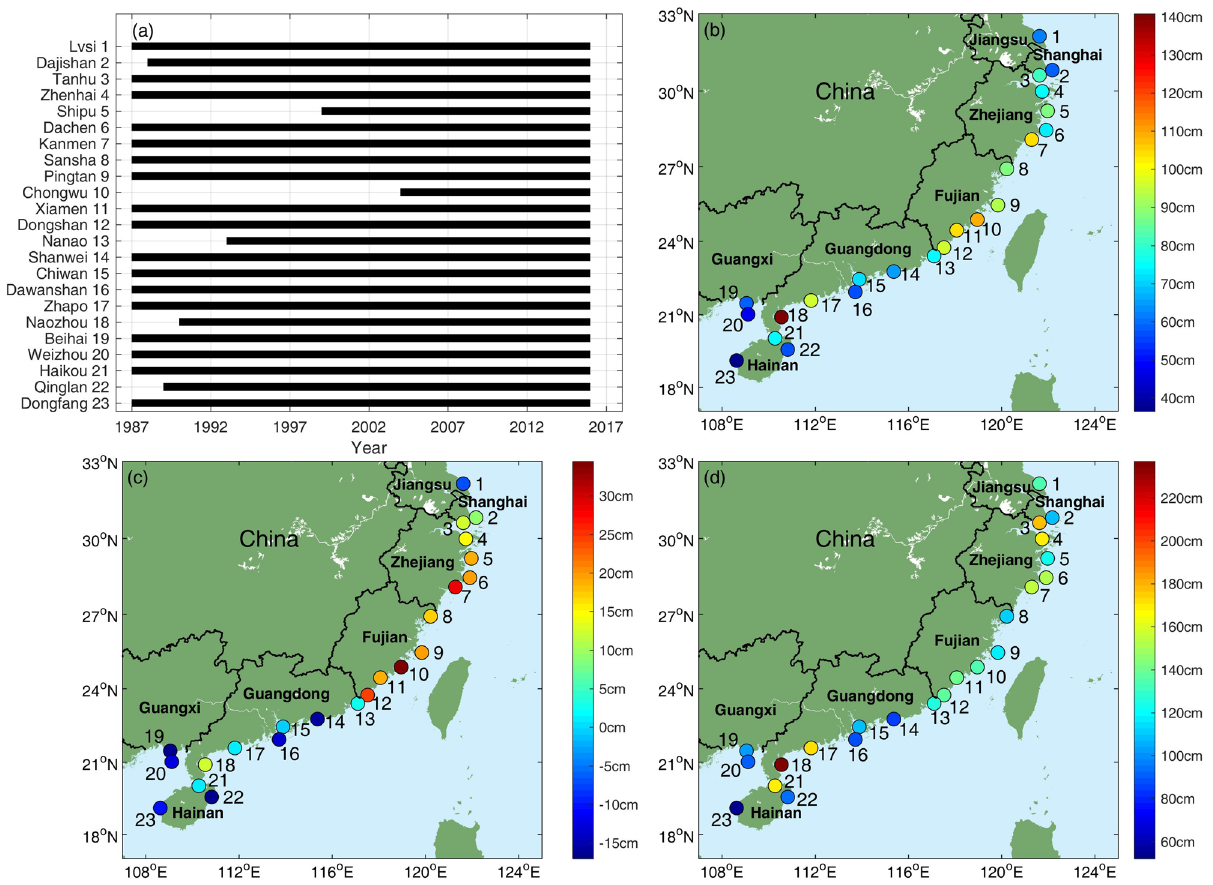
Figure 1. ( a ) Data duration of tide-gauge stations. ( b ) The average AMTSS in El Niño years. ( c ) Difference in the average AMTSS between El Niño and non-El Niño years. ( d ) The maximum values of AMTSS in El Niño years. Figures were plotted using MATLAB R2018b (http:// www. mathw orks.